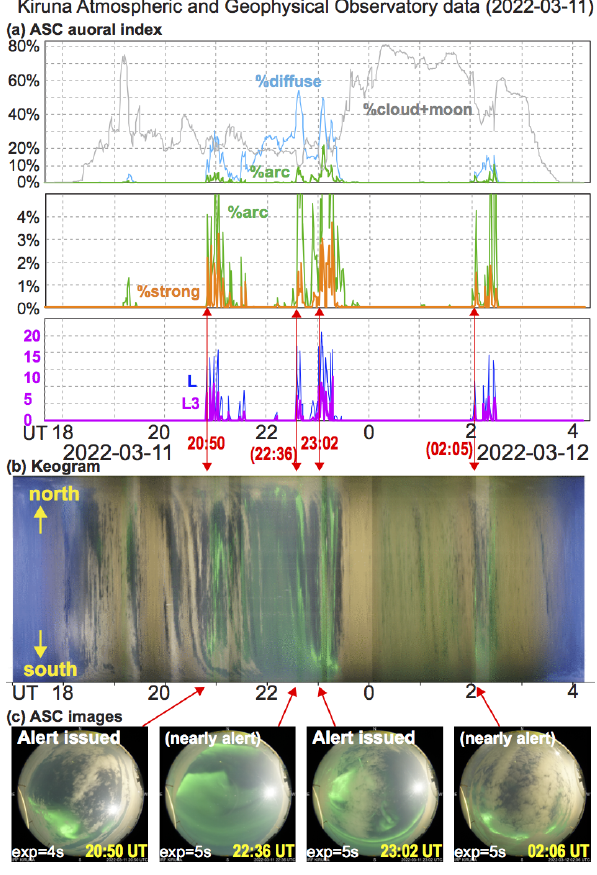
Figure 6. An example of (a) the ASC auroral index over one night (11–12 March 2022) with both active aurora and occasional cloud. As reference, (b) keogram over the same night and (c) all-sky im- ages at the time of the auroral alert issued for Level 6 activities. Each image is taken toward the sky with north at the top, and hence east (west) is on the left (right). All images again include the Moon or Moon-brightened cloud. The automatic exposure time is 4 or 5s for the displayed